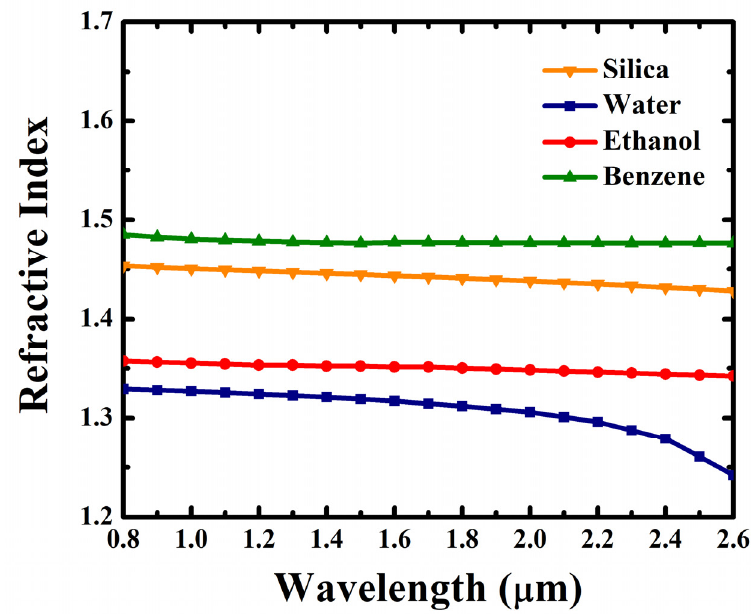
Figure 2. Refractive index of silica and test analytes, water, ethanol and benzene, at 0.8–2.6 µm operating wavelength [31–34].